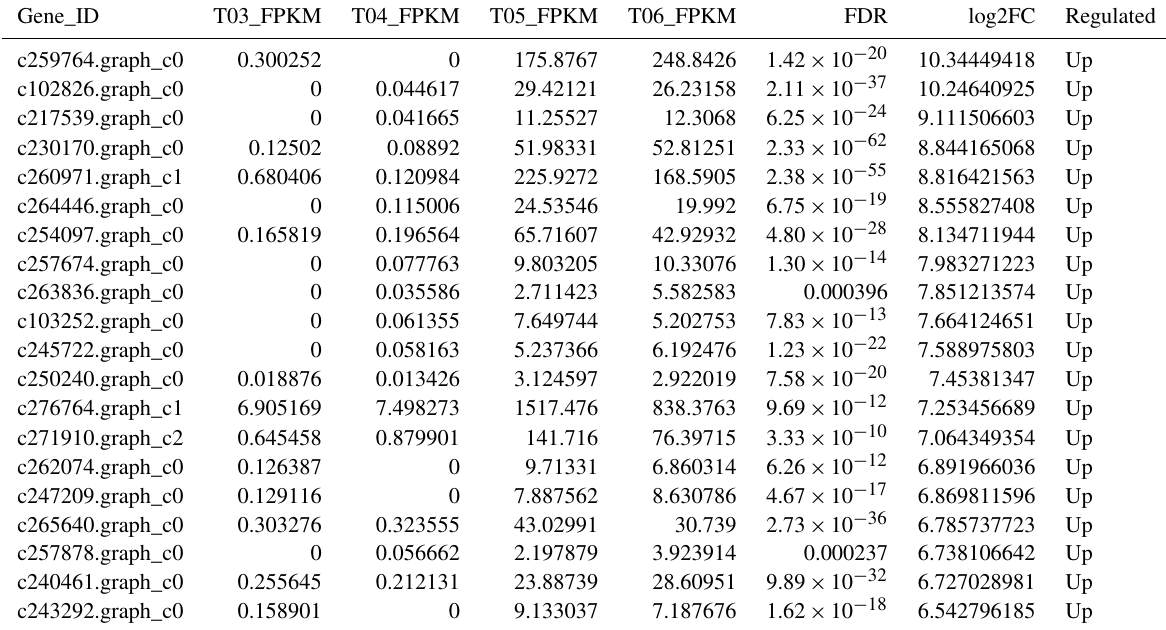
Table 3. The top 20 DEGs found to be enriched, i.e., more highly expressed, in the mulard